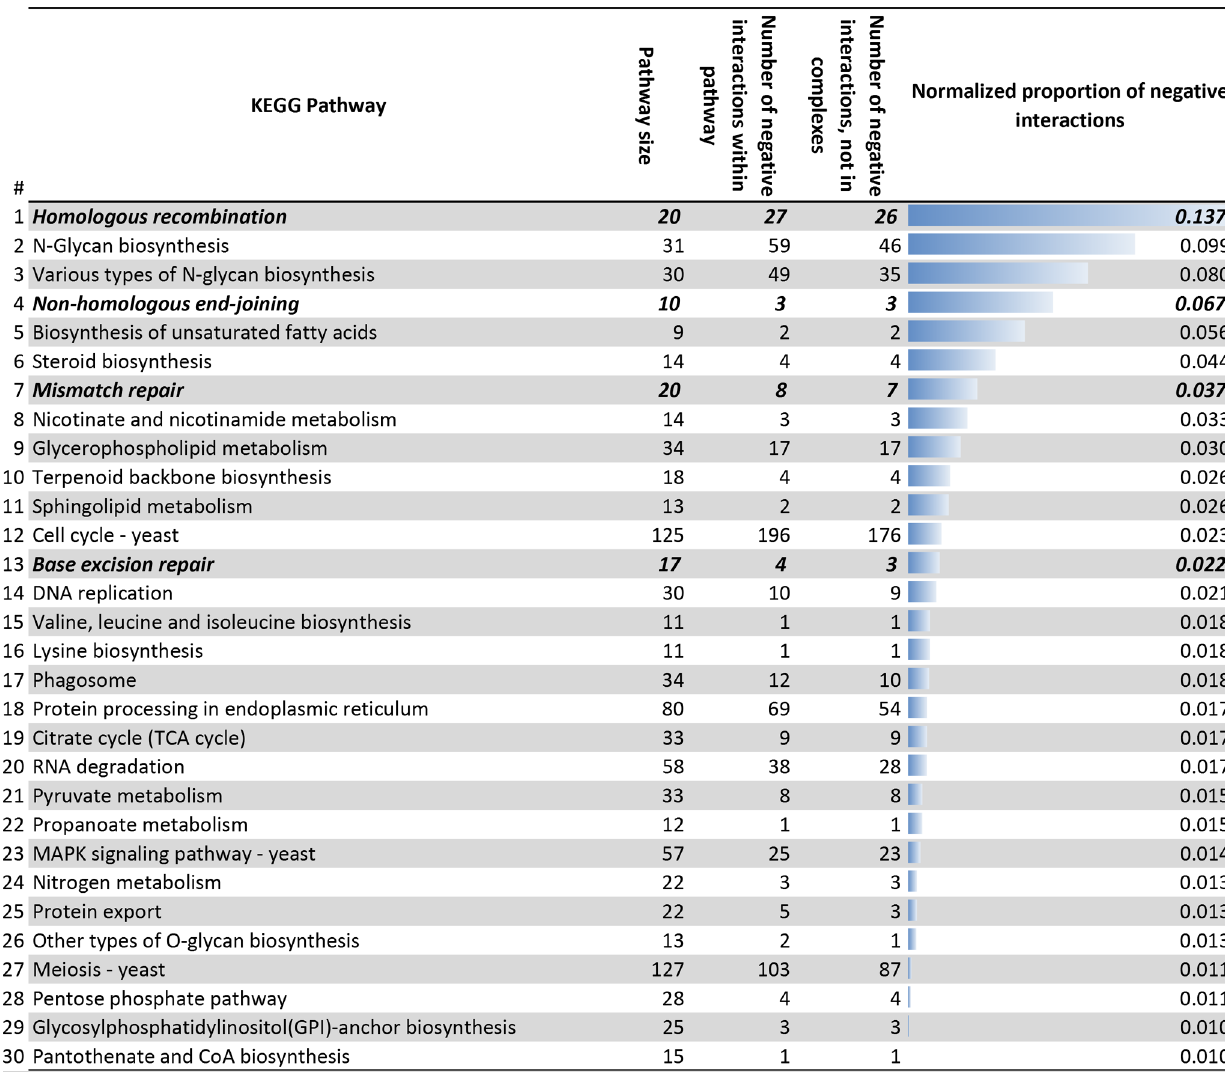
Figure 2. Normalized proportion of negative genetic interactions within one KEGG pathway. The proportion is related to the number of all possible pairwise interactions S ( S 2 1)/2, where S is the size of the KEGG pathway. Negative interactions between components of a molecular complex were excluded (compare the fourth and the fifth columns). We counted the normalized number of negative genetic interactions within one pathway using recent data on the genome-wide screening of genetic interactions in yeast from [5], using the most stringent filter on the epistasis measure e . Definitions of yeast signaling and metabolic pathways were taken from KEGG database [30]. Only KEGG pathways with a normalized proportion of $ 1% are shown. DNA repair KEGG pathways are highlighted in bold.